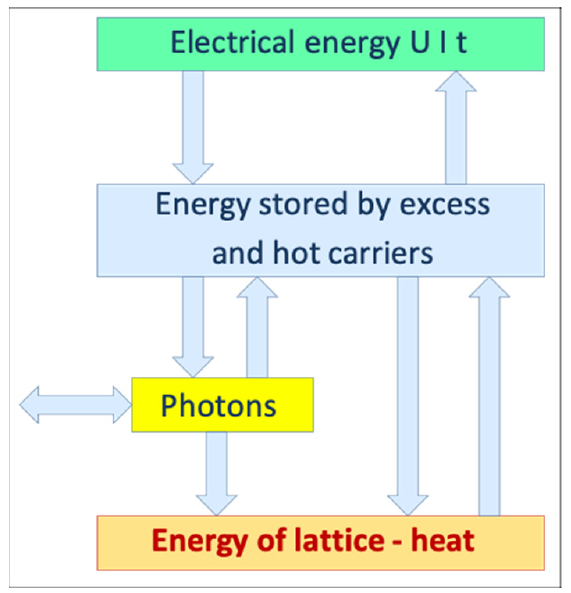
Figure 4. Simplified scheme of energy flow in semiconductor structure. The simple vertical structure of the GaN LED diode presented in Figure 3a can be considered as some kind of p- ν -n structure, in which the layer ν is represented by the MQW layer. It allows, by analogy, to transfer the formulas describing the energy transfers in the p- ν -n diode to the energy transfers in the model for the GaN LED diode. The developed model takes into account optical phenomena such as photon absorption on electrons and photon generation in radiative recombination. Under the acceptable assumption that the current carrier exchange takes place in the MQW only, the radiative recombination dominates, and its contribution to the total recombination is determined by the internal quantum efficiency IQE. Hence, the model covers the following second-stage processes: Ohmic losses (Joule losses) are described by the well-known formula: